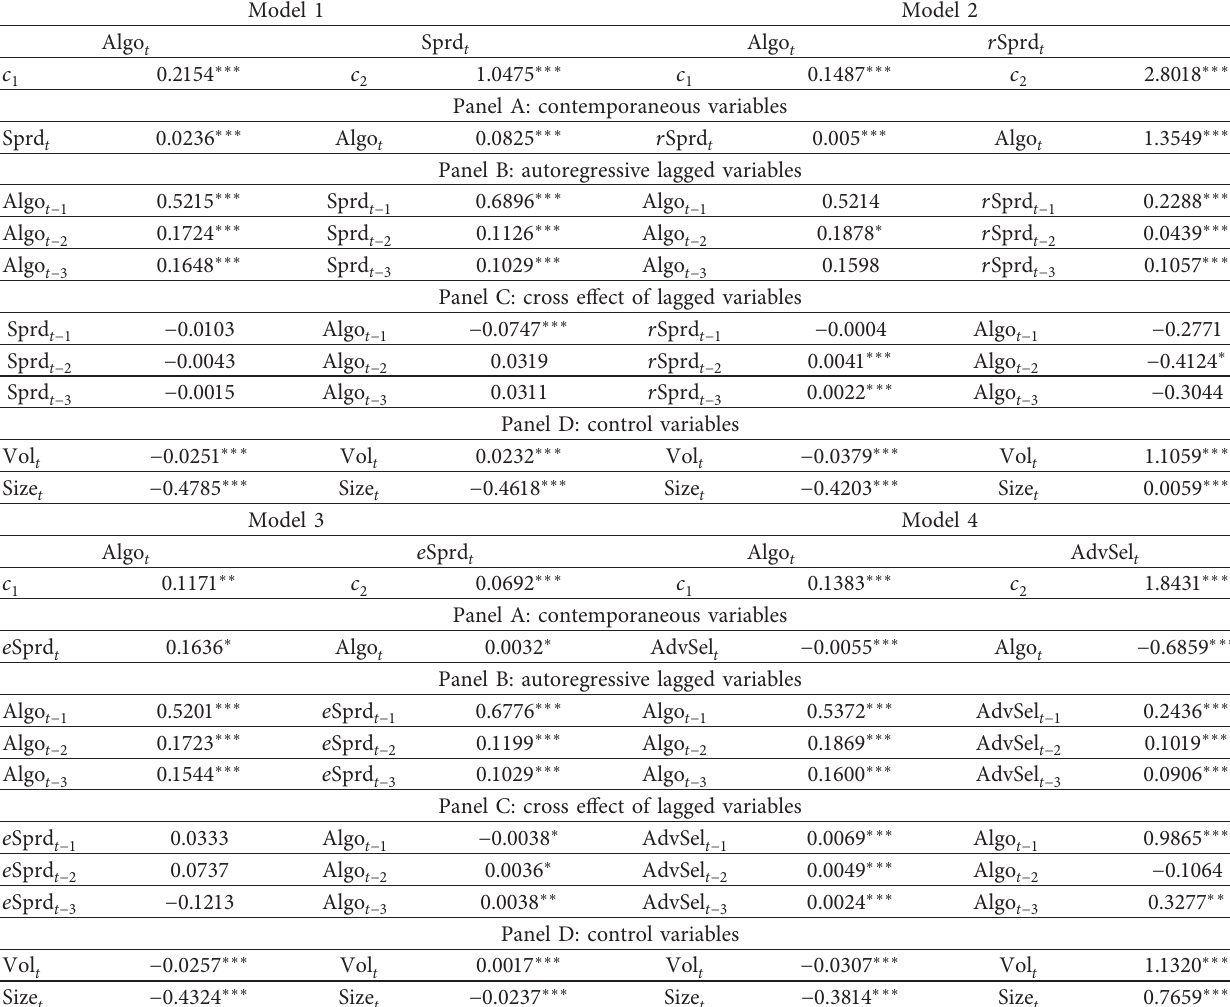
Table 3: Relationship between algorithmic trading and liquidity indicators (July 1, 2014–May 31,